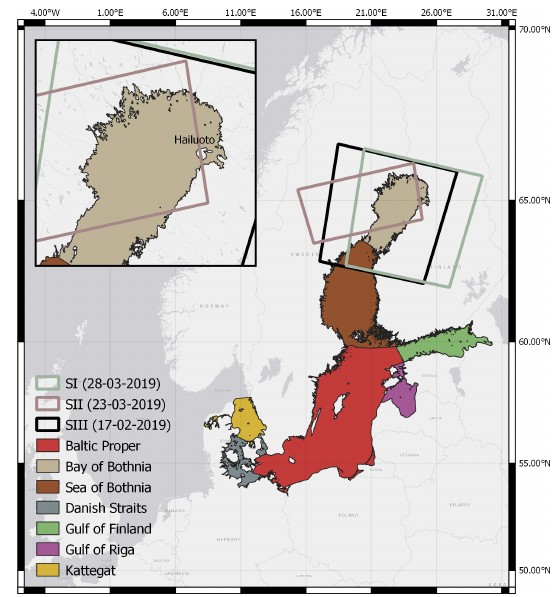
Figure 1. The Baltic Sea and its sub-basins as defined by the Baltic Marine Environment Protection Commission – Helsinki Com- mission (HELCOM) available at http://maps.helcom.fi/website/ mapservice/ (last access: 21 October 2020). A highlight of our study area, the Bay of Bothnia, is inset top left. The synthetic aperture radar (SAR) frames utilised for cases, described in more detail in Table 1, are outlined as well by using the kml files provided in the SAR product. The Environmental Systems Research Institute (Esri) World Light Gray Base is used for background map, available at https://felix.rohrba.ch/en/download/2696/ (last access: 21 October